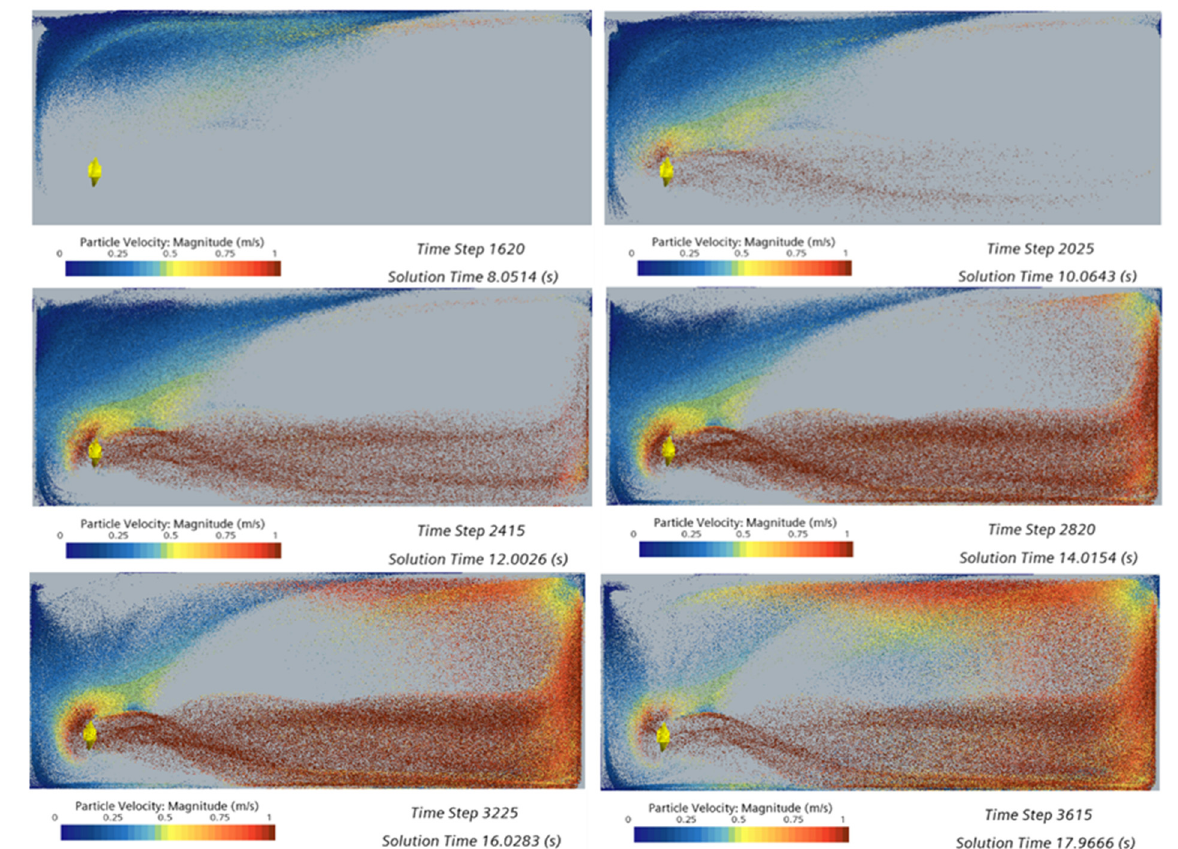
Figure 10. Absorption-injection